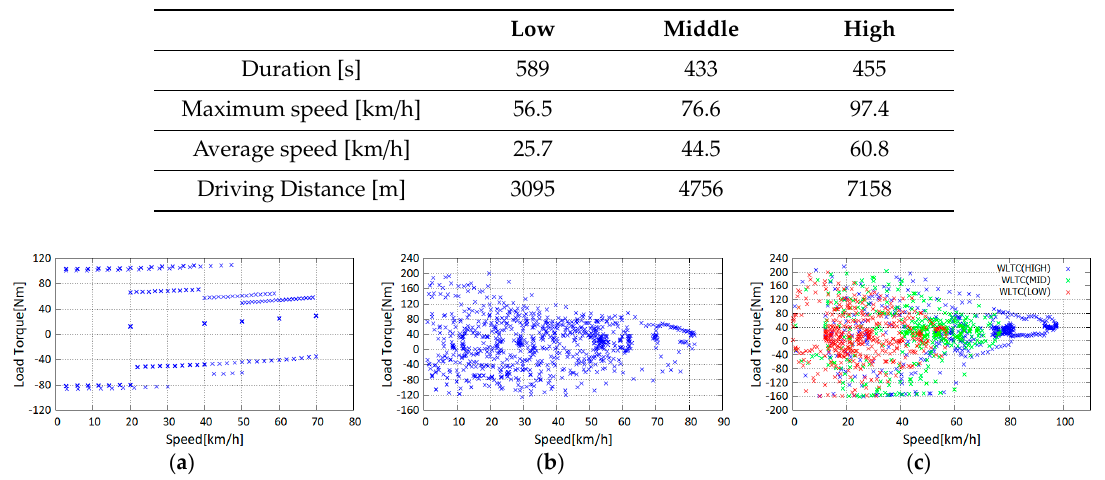
Table 3. Specifications of WLTC Class 3.